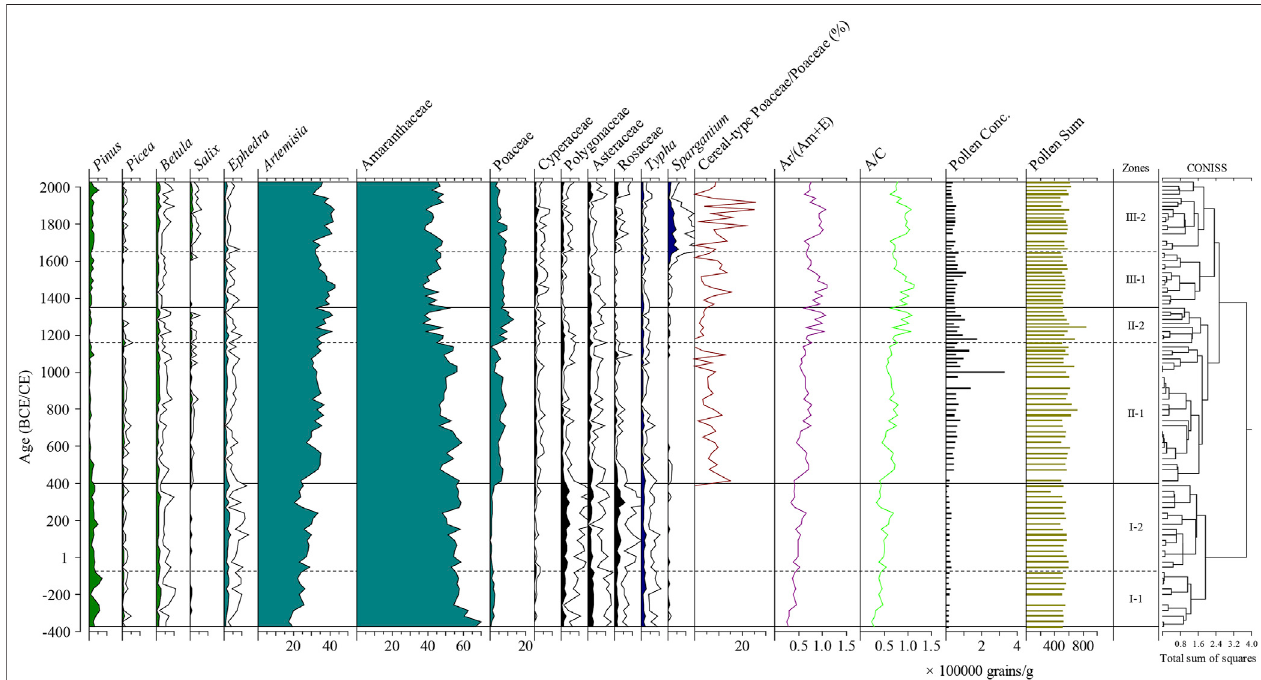
FIGURE 3 | Pollen percentage diagram for core JL18-02-A spanning the last 2400 years.